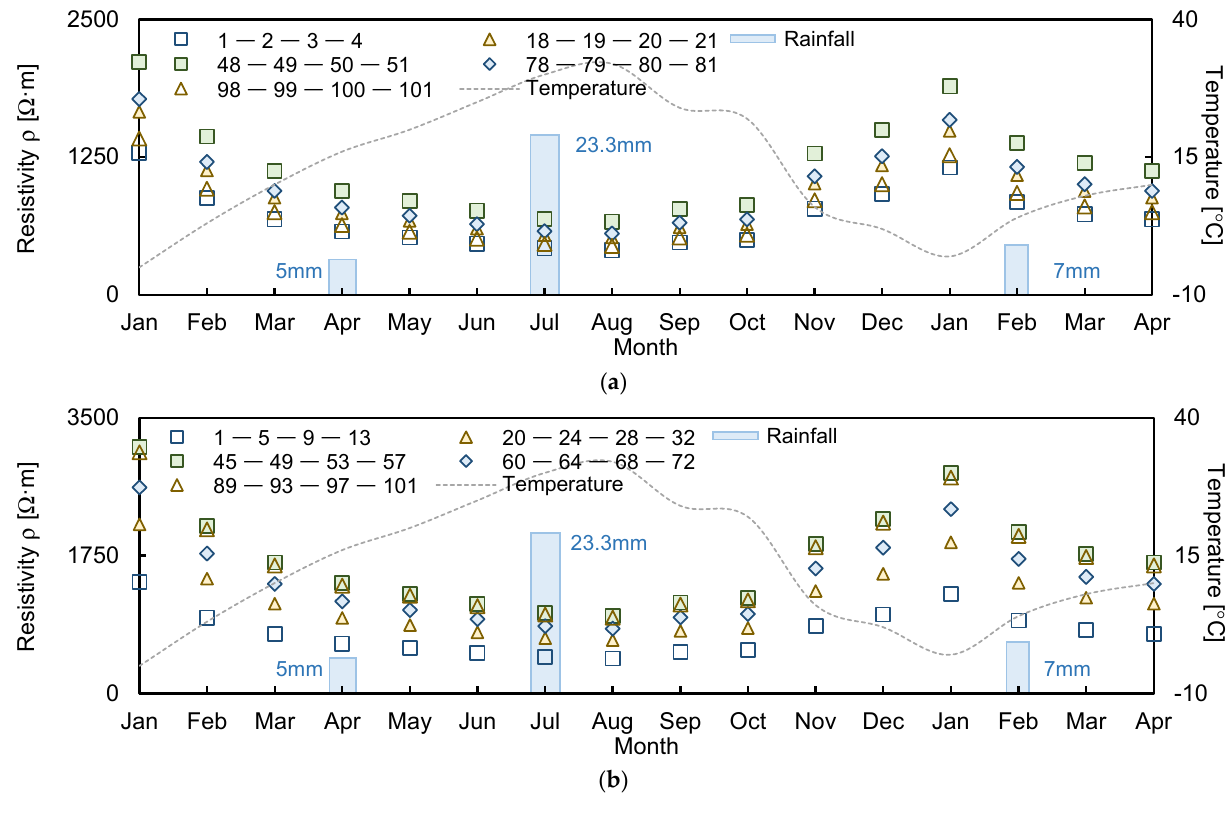
electrodes are displayed in Figure 3, which indicates that the distributions of electrical resistivity were based on electrode spacings of 1, 4, 7, 10, 13, 16, 19, and 21. The electrodes were installed at 2 m intervals. For example, electrode spacings of 1 and 21 denote 2 and 42 m intervals of the electrodes, respectively. Temperature and rainfall values were